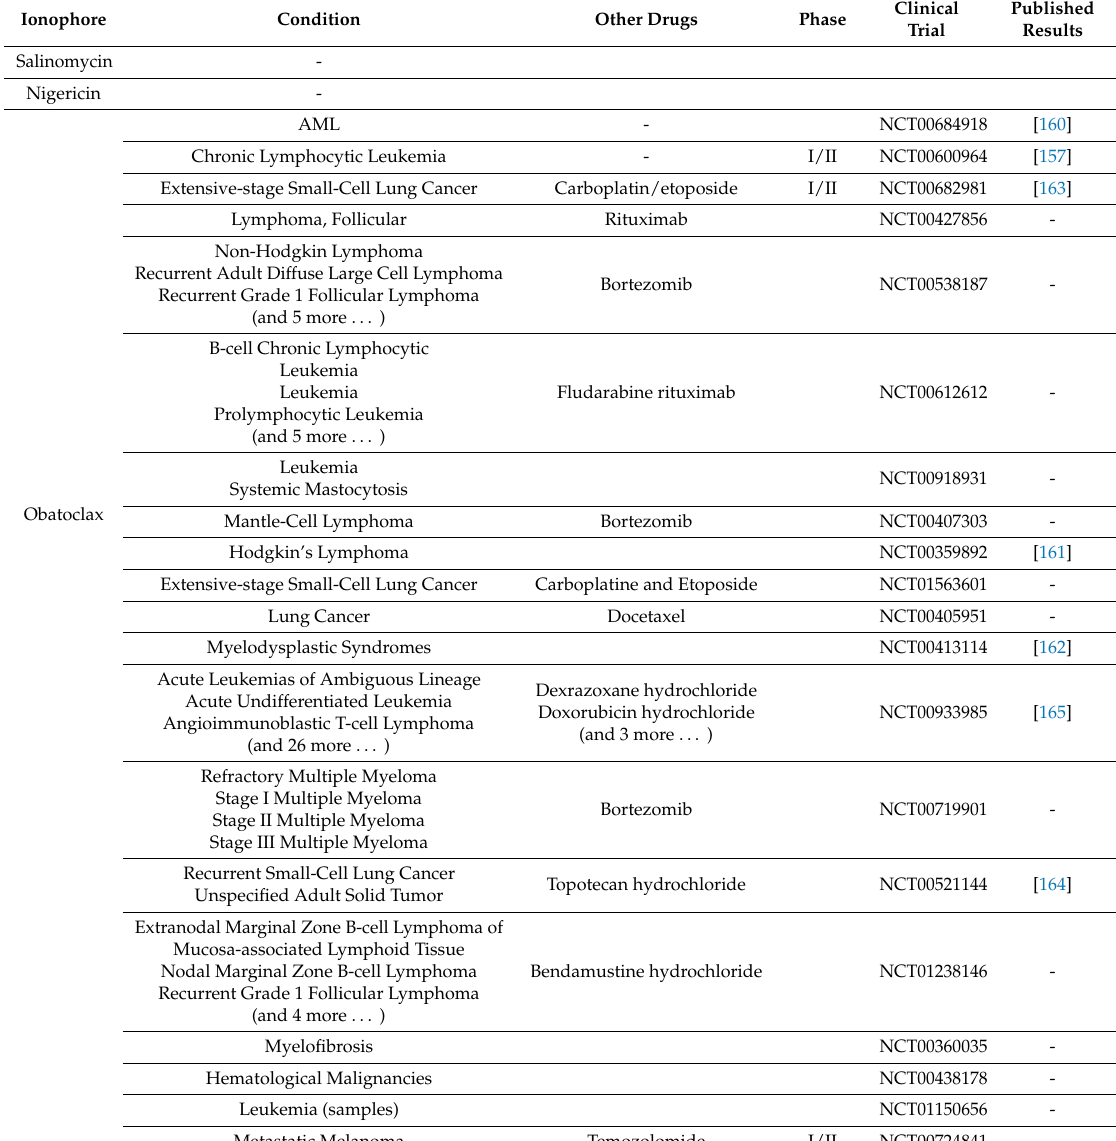
Table 2. Registered clinical trials (www.clinicaltrials.gov) and published